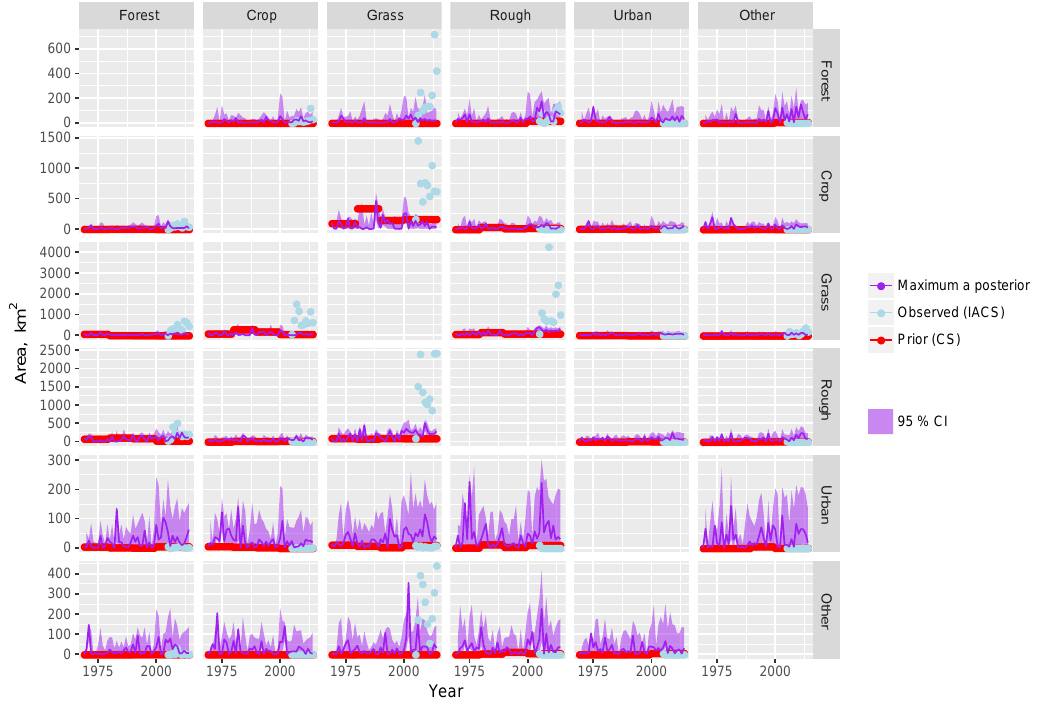
Figure 5. Prior and posterior distributions of the transition matrix B , representing the gross area changing from the land use in each row i to the land use in each column j each year from 1969 to 2015. Red lines show the prior estimate from the Countryside Surveys. Pale blue points show estimates from IACS plus Corine and NFEW. The maximum a posteriori estimates after assimilating all data sources are shown in purple. The shaded band shows the 2.5 and 97.5% quantiles of the posterior distribution. Note the y scale is different for each